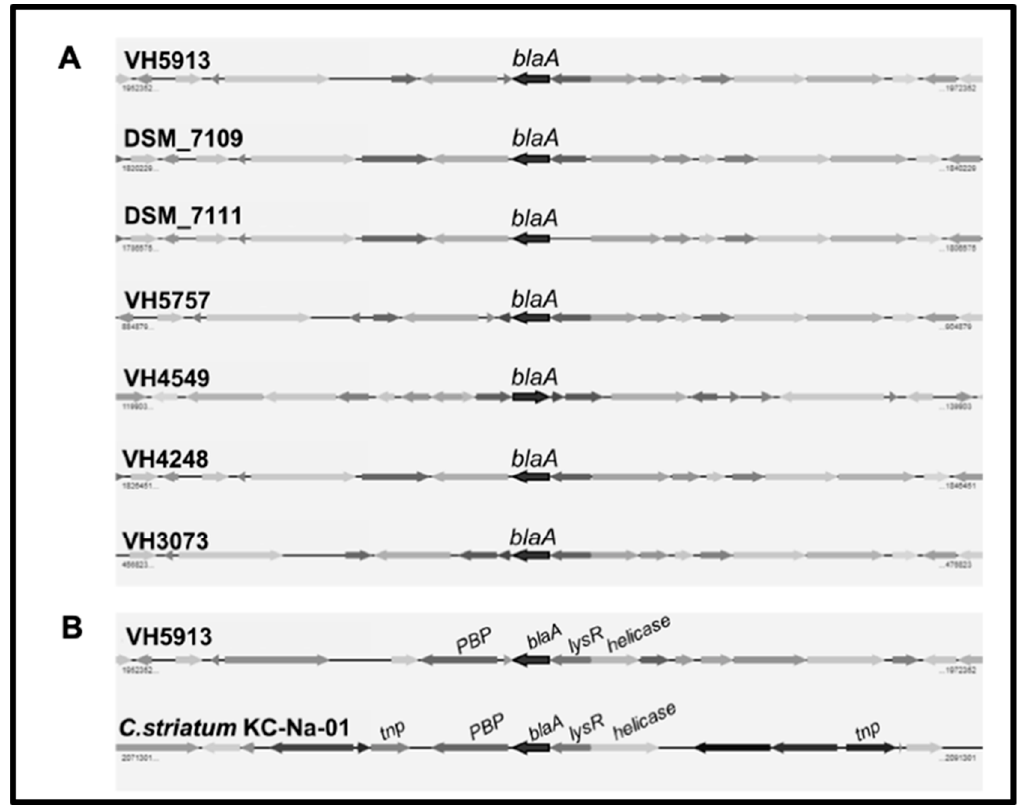
Figure 2. A : Genomic context of the blaA gene in seven C. urealyticum . B : Comparison among the blaA - containing regions of C. urealyticum VH5913 and Corynebacterium striatum